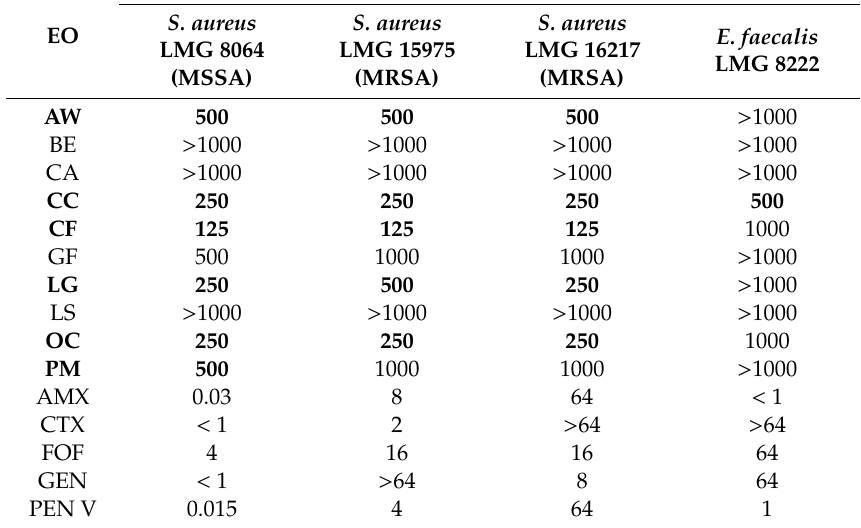
Table 3. Direct activity of the essential oils against the Gram-positive strains ( n = 6). In bold, the most promising